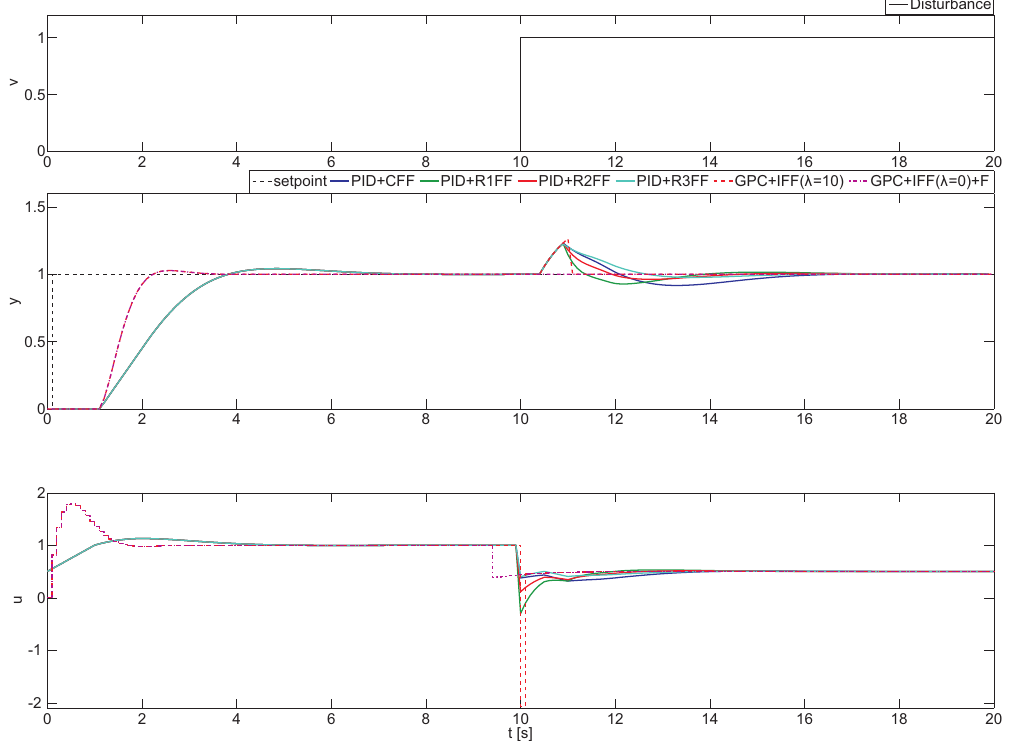
Figure 4. Comparison of compensation performance for PID (Proportional - Integral - Derivative) and GPC (Generalized Predictive Control) approaches for non-realizable feedforward